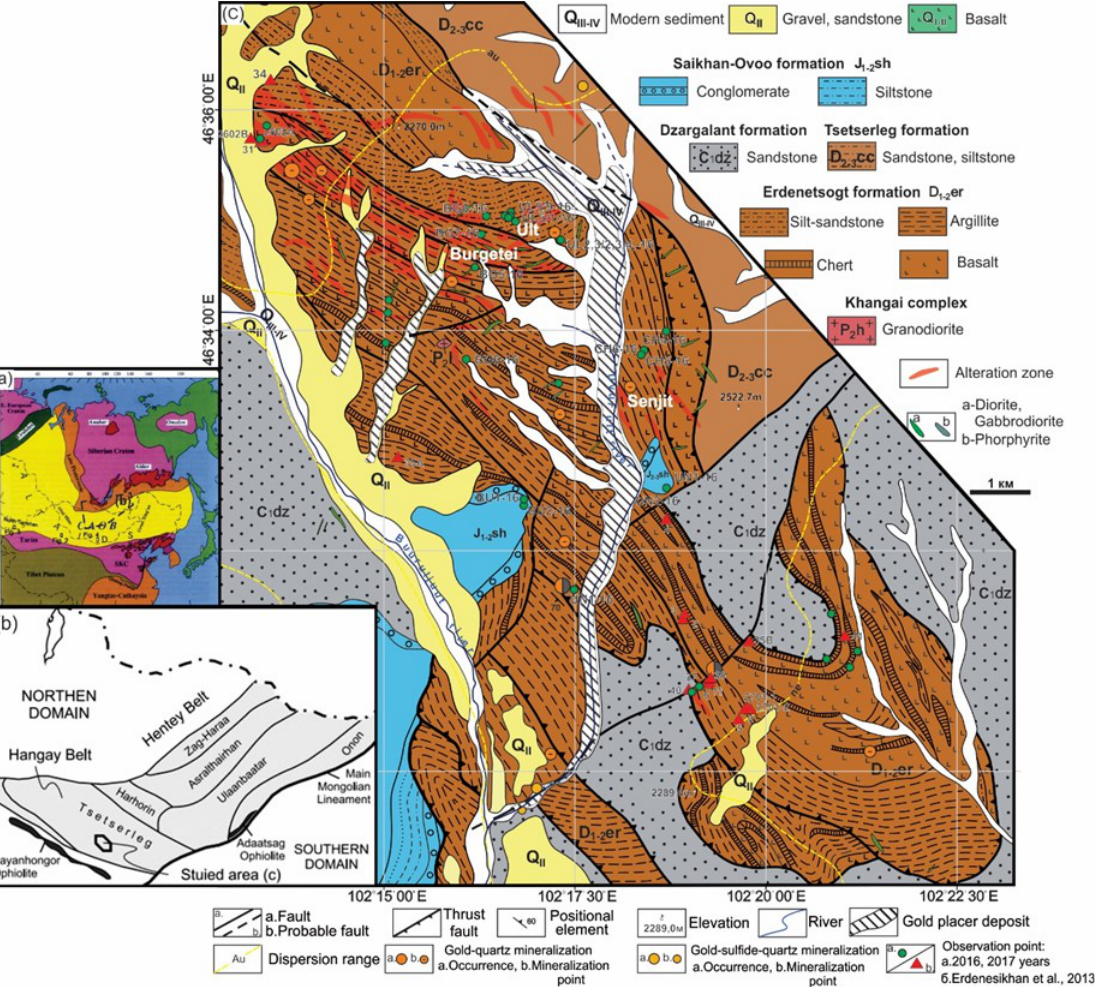
Figure 1 . Geology and natural resource map of Ult area of the Uyanga district (c) (modified from Lhundev et al., 1994) Location of study area: Central Asia orogenic belt (а) Tsetserleg accretion terrain of Khangai-Khentei Orogenic Belt (b) (Tomurtogoo,